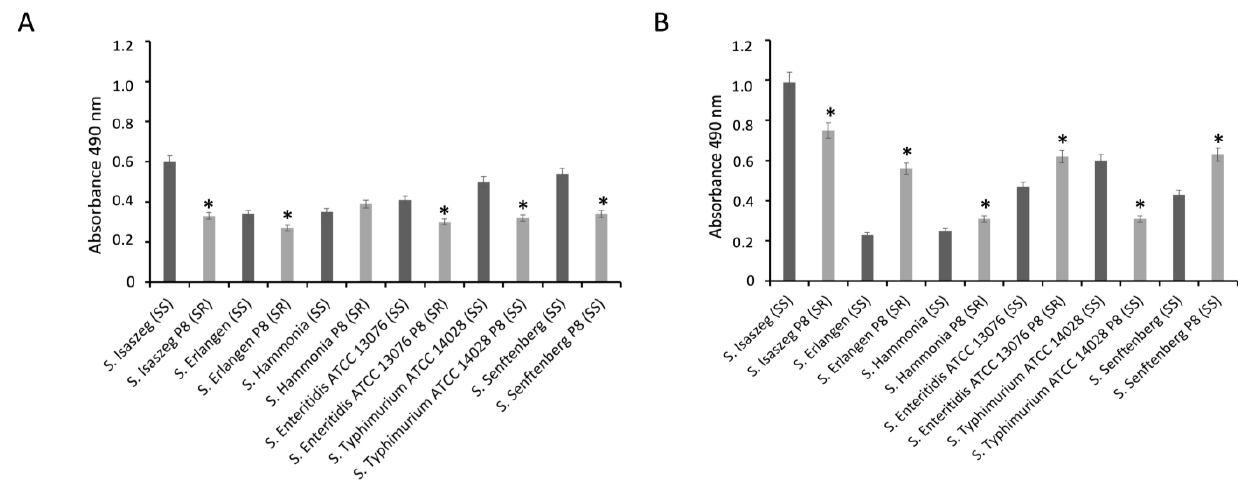
Figure 2. Analysis of complement C1q ( A ) and C3c ( B ) deposition on S. enterica cells. Cells of the WT serum-sensitive (SS) strains and the serum-resistant (SR, P8) were incubated in 50% SPPP for 12 min at 37 °C. C1q and C3c components deposited on cells were identified by indirect ELISA with appropriate antibodies as described in the methods. Data are presented as the means of standard deviations of triplicate determinations from three independent experiments, after subtraction of negative control (A 490 0.125); * indicates a statistically significant difference in values ( p < 0.05) with respect to the data obtained for WT strains.